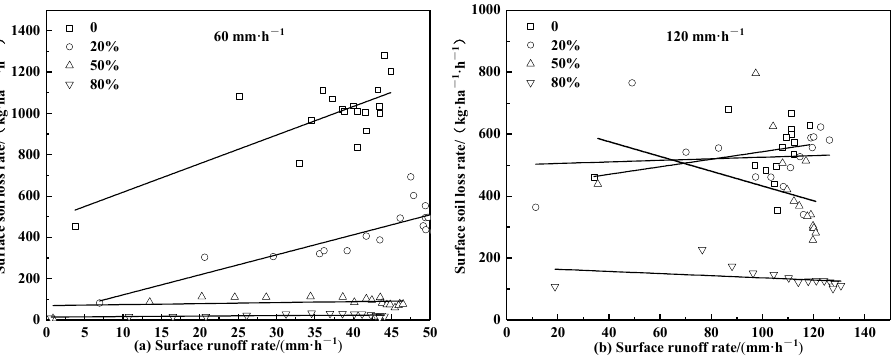
Figure 6. Relationship between surface runoff rate and surface soil loss rate in young red soil citrus orchards at 60 mm/h ( a ) and 120mm/h ( b ) rainfall intensities under different straw coverages. Under heavy rain conditions (120 mm/h), the scatter points’ distribution without straw coverage was mainly concentrated in the upper right corner. In the more concentrated part, the scatter showed a vertical distribution from top to bottom. This may be because, after the local surface runoff reached a stable state, the surface soil rapidly began to crust, and the soil that could be eroded decreased; this, in turn, caused the erosion rate to decrease under a high runoff intensity. The scattering characteristics of the 20% straw cover spread from the lower-left corner to the upper-right corner, and its surface soil loss rate increased slightly with the increase in surface runoff rate. The distribution of scatter points for 50% and 80% straw coverage were mainly concentrated in the lower right corner, and their surface soil loss rate decreased with the increase in runoff intensity. The scatter points’ distribution of 80% straw coverage was significantly lower than that of other straw coverages. 4. Discussion Straw mulching can effectively reduce the surface runoff coefficient of young lime- soil citrus orchards and increase the subsurface flow and groundwater flow coefficient at the same time. After straw mulching, the runoff source of young lime-soil citrus orchards changed from the surface to underground. Under the same rainfall intensity, straw mulching can reduce the direct contact between raindrops and surface soil and reduce the flow rate of surface runoff. Increasing straw coverage will weaken the kinetic energy of raindrops, and improve rainwater infiltration, soil flow, and groundwater flow [40]. The effect of straw mulching on runoff coefficients in red soil was not significant. During rainfall, the impact of raindrops on the exposed surface soil will cause soil surface crusting, reduce soil infiltration, and hinder rainwater infiltration [39]. To ensure that the initial water content is basically the same before each test, precipitation with a rainfall intensity of 30 mm/h was carried out 24 h before the simulated rainfall test. Studies have shown that the stable infiltration rate of soil in the karst area of the study area is 42.0–255.0 mm/h. In this study, 30 mm/h rainfall intensity was used for pre-wetting. The stable infiltration rate of the soil in the study area is much higher than the rainfall intensity for pre-wetting, so surface runoff will not occur during pre-wetting [41]. In the formal simulated rainfall test, the soil moisture basically reached the saturated state, the infiltration rate of the red soil in the karst area was low, and the infiltration decreased with the increase in previous water content. During rainfall, the surface runoff is produced quickly due to the lower soil infiltration rate and greater rain intensity. Rainwater can easily generate runoff directly onto the straw, rather than produce surface runoff after contact with the surface soil, so its impact on the runoff coefficient is not significant [42]. McDowell’s results showed that a higher early soil water content will increase surface runoff [43].